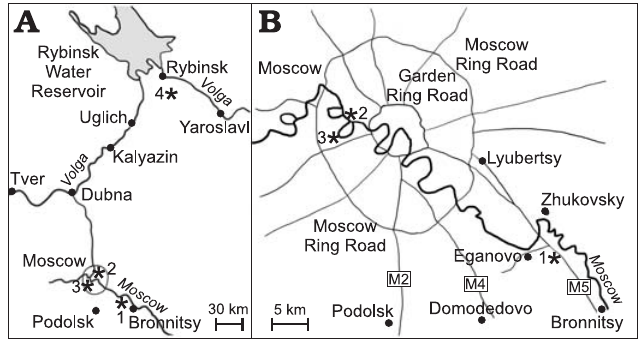
Fig. 1. Maps of Central Russia ( A ) and Moscow area ( B ) with indicated localities (asterisks): 1, Eganovo (55°32’08.28”N; 38°03’10.47”E); 2, Mnevniki (55°46’4.12”N; 37°28’4.67”E); 3, Kuntsevo (55°44’40.83”N; 37°26’16.23”E); 4, Cheremukha (Mikhalevo-Ivanovskoe) (57°57’25.68”N;